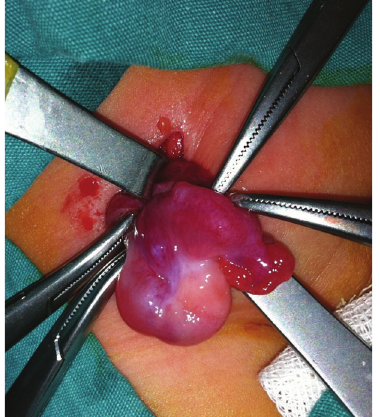
Figure 3: This intraoperative photo well demonstrates the right ovary and the fallopian tube in the hernial